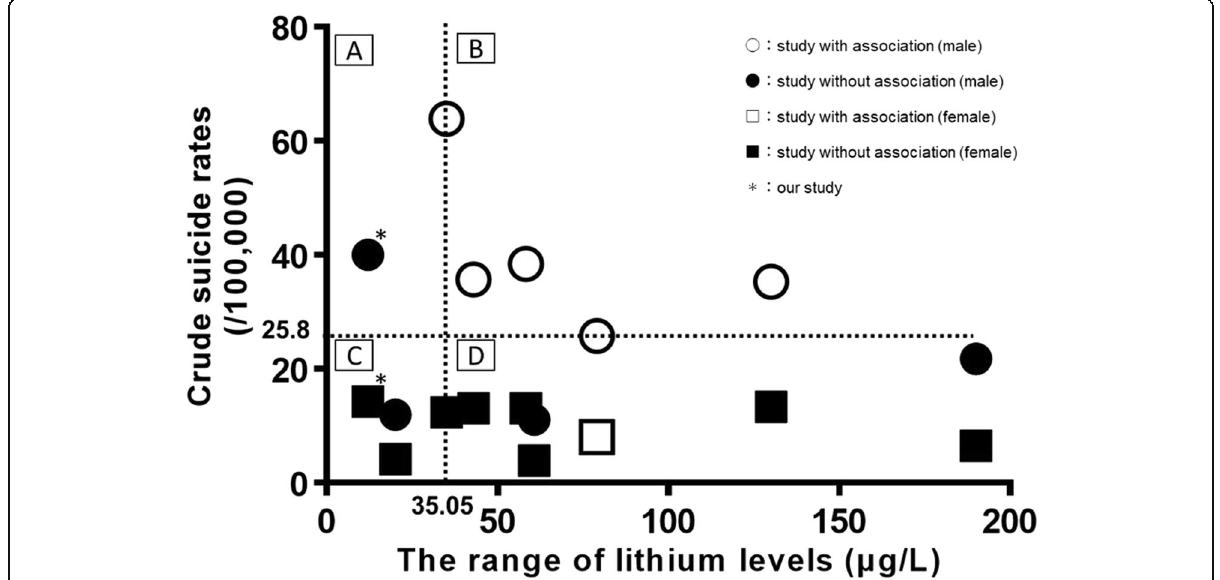
Fig. 3 The range of lithium levels in drinking water and crude suicide rates (per 100,000 population). Studies with an association: these studies showed a significant association between lithium levels in tap water and suicide; if lithium levels increased, suicide rates decreased. Studies without an association: these studies did not show a significant association between lithium levels in tap water and suicide. The range of lithium levels: max value minus min value. The dotted lines show minimum levels of the range of lithium levels and crude suicide rates among studies with an association (male). Areas A, B, C, and D are divided by dotted lines (the horizontal line shows crude suicide rates 25.8/100,000, and the vertical line shows the range of lithium levels 35.05 μ g /L). We used lithium levels from previous studies [9, 10, 13 – 17, 31], as well as crude suicide rates (per 100,000 population) from statistics on suicide provided by the Ministry of Health, Labor and Welfare in Japan and WHO [32]. If crude suicide rates of the survey year were not available, we substituted crude suicide rates of the nearest survey